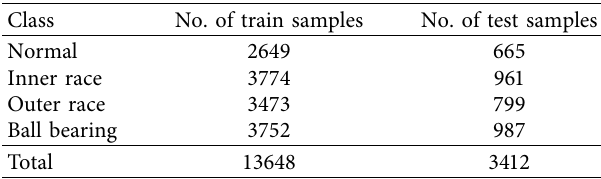
Table 3: Dataset A for fault type